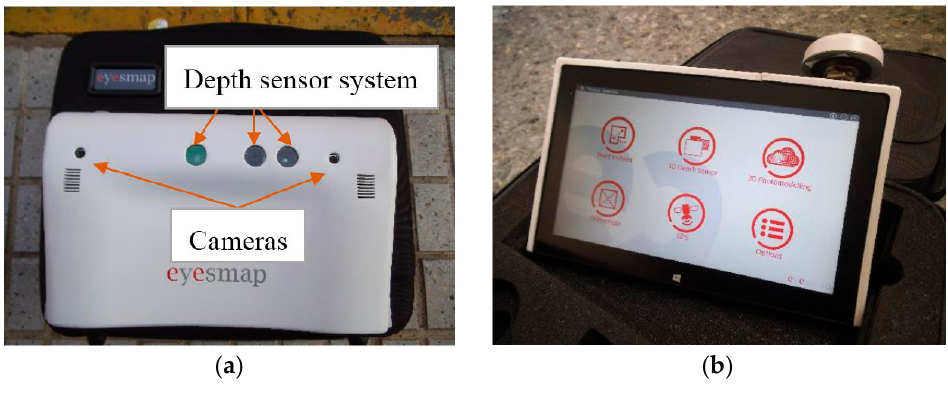
Figure 1. EyesMap (EM): ( a ) back; and ( b ) front.